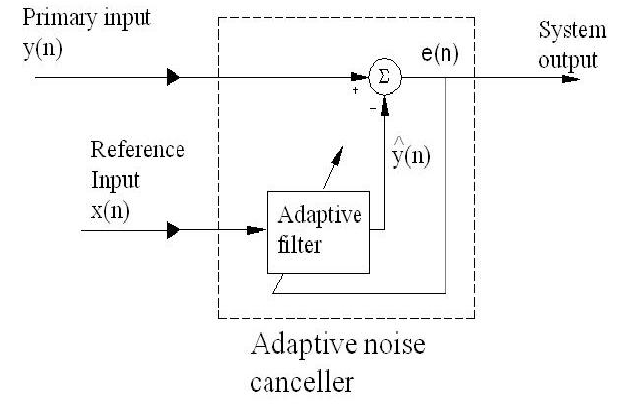
Figure 1. Schematic diagram of the